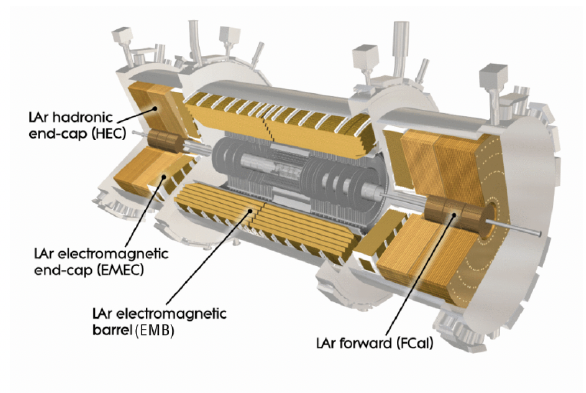
Figure 1. Schematic view of the different sub-detectors composing the ATLAS Liquid Argon (LAr) Calorimeter system [1,2].